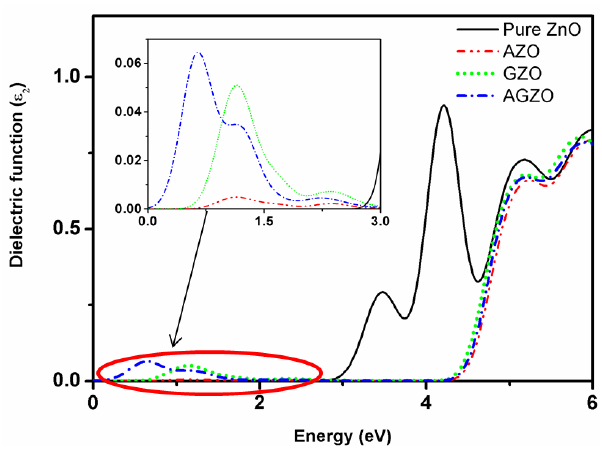
Figure 5. Imaginary part of the dielectric function of Al/Ga ‐ doped ZnO.